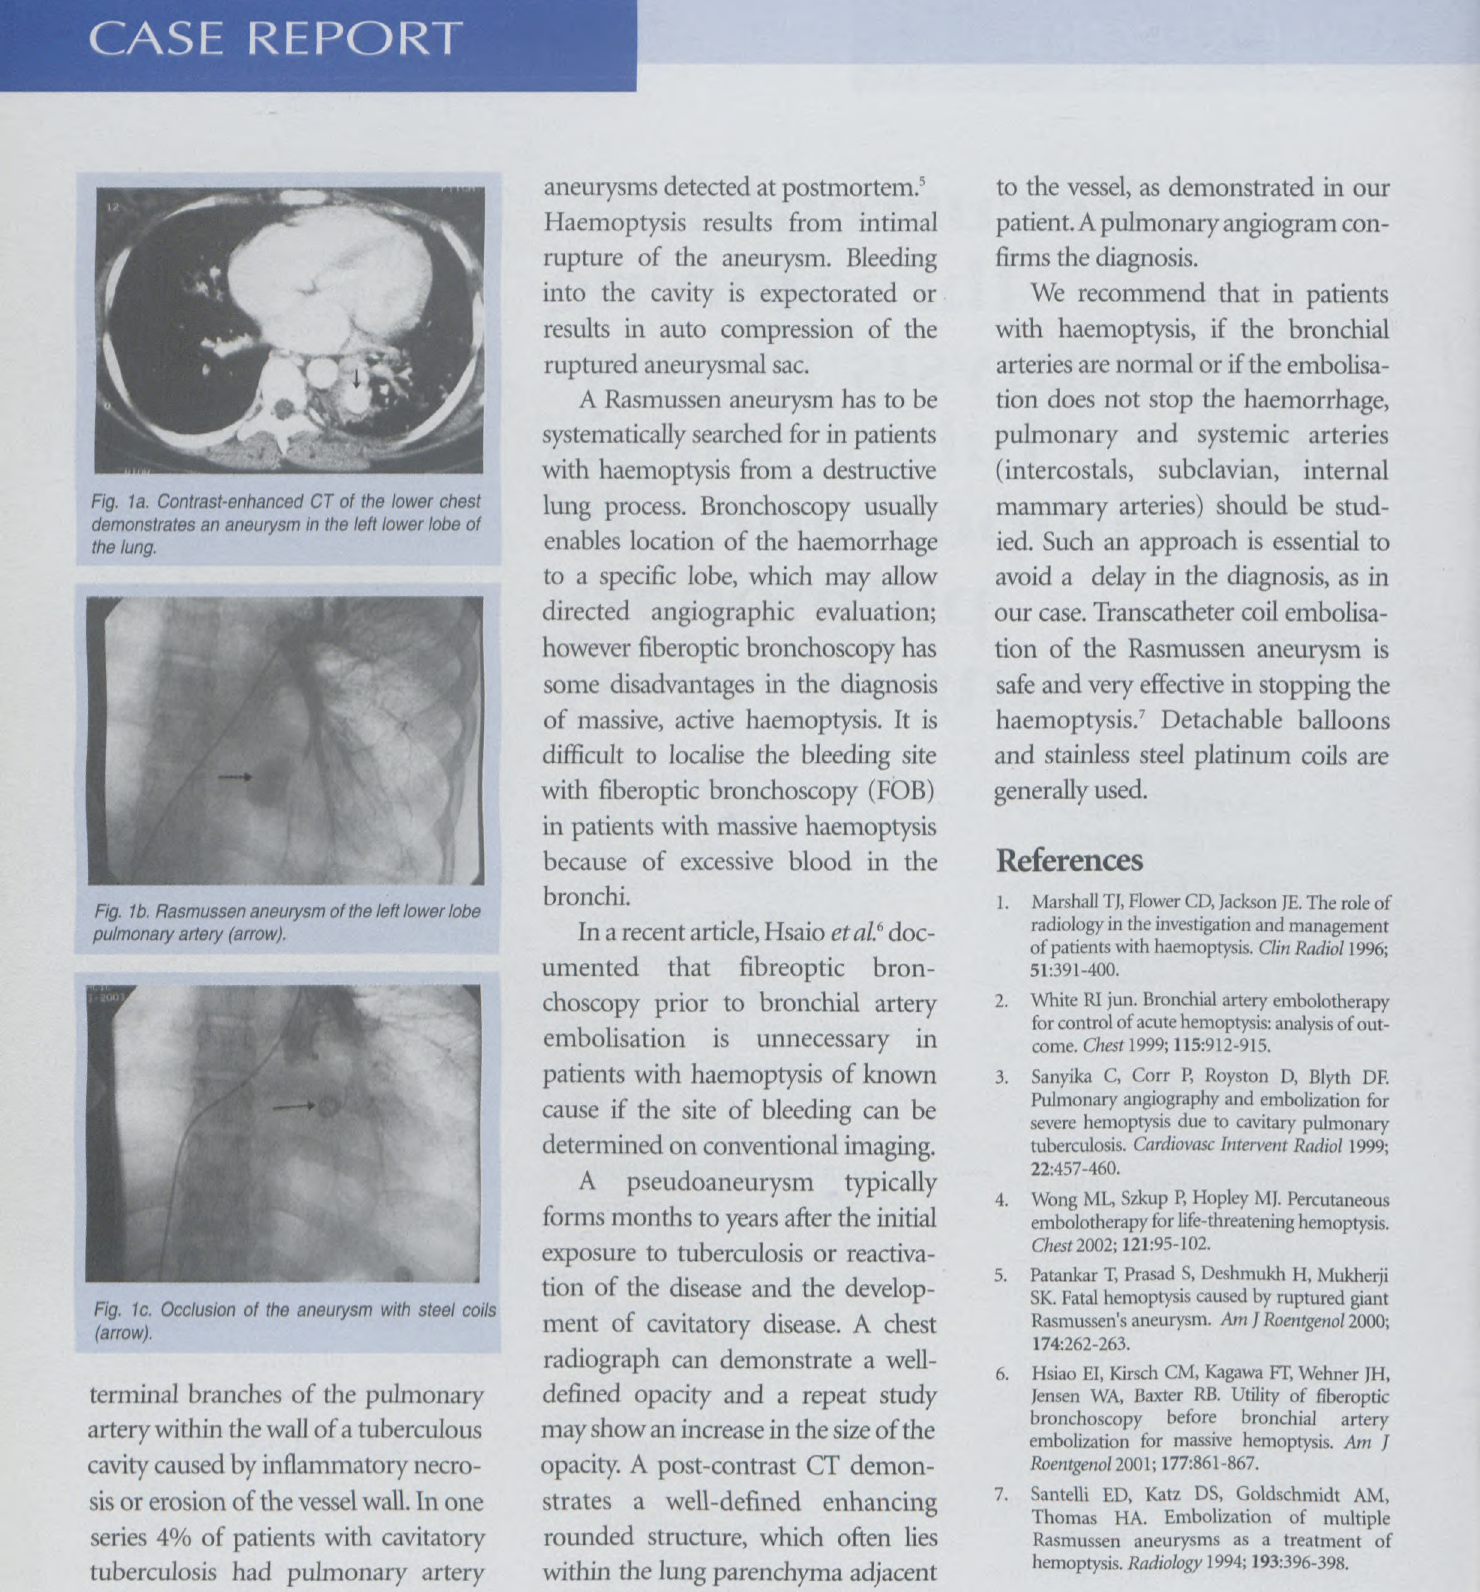
Fig. te. Occlusion of the aneurysm with steel coils